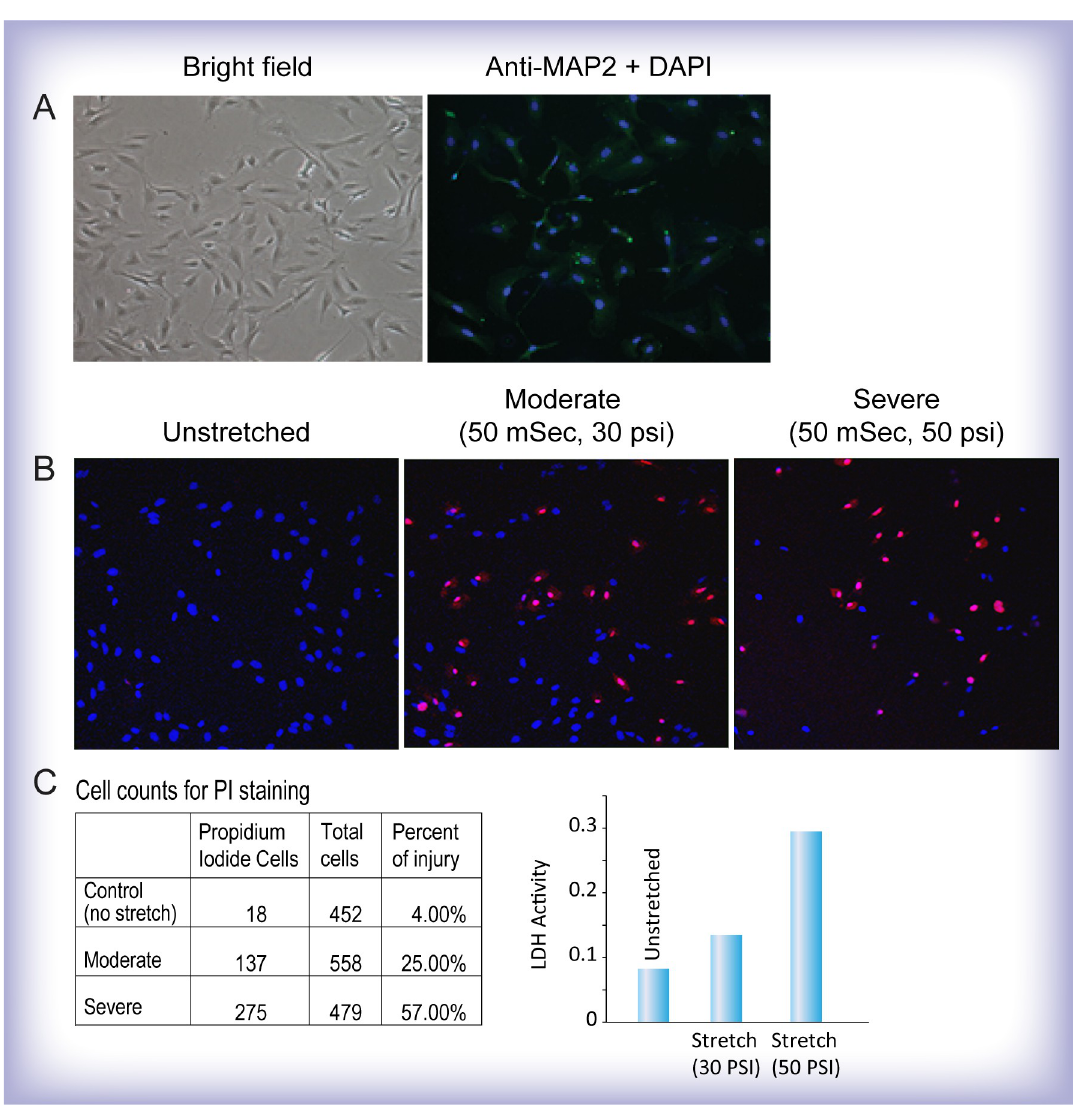
Fig 2. Characterization of the immortalized H19-7 hippocampal cell line. (A) H19-7 cells shown in bright field and stained positive with a neuronal marker Anti-MAP2 and DAPI. (B) Stretch injury levels were assessed using propidium iodide (PrI, red) and Hoechst 3342 (blue) staining. Unstretched H19-7 hippocampal neurons showed few PrI-stained cells. Increasing numbers of PrI-positive cells were detected in H19-7 cells subjected to a moderate injury level of 50 msec, 30 psi of pressure (~25% cell injury) and a more severe injury level of 50 msec, 50 psi (~57% cell injury). (C) The cell counts for PrI staining corresponded to increased levels of lactate dehydrogenase (LDH), a marker of tissue damage, released from stretch-injured cells.